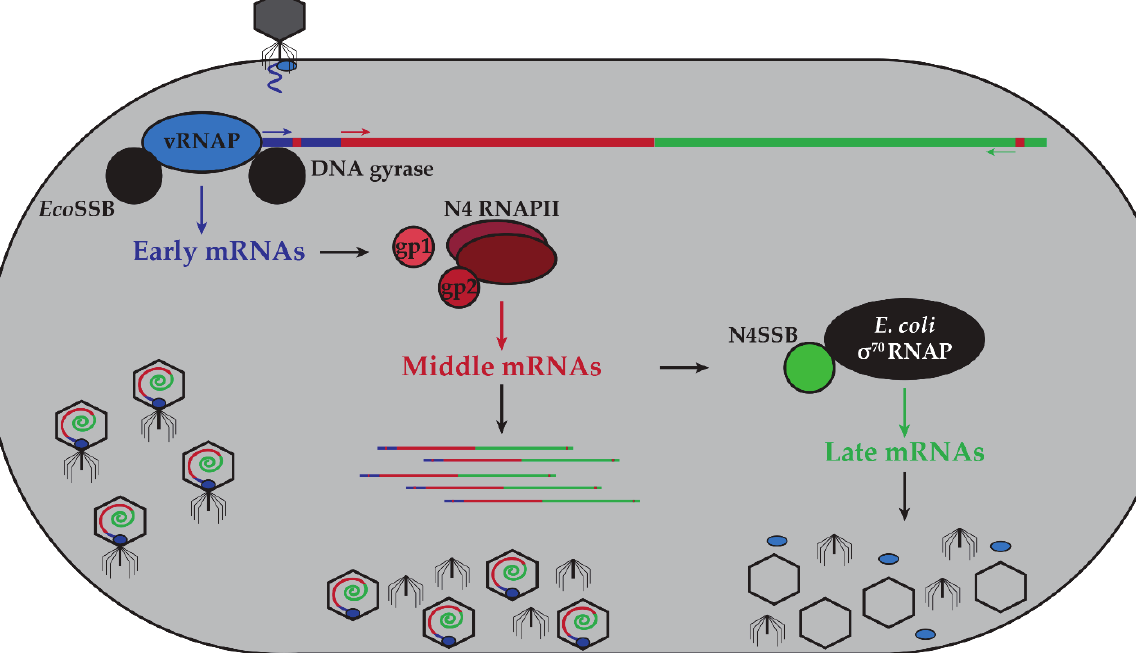
Figure 1. Schematic of transcriptional program controlling the N4 life cycle. Upon interaction with its receptor, NfrA, N4 injects vRNAP and genomic DNA into the host. Host DNA gyrase introduces negative supercoils into the phage genome, driving early promoter hairpin extrusion. Eco SSB stabilizes the hairpin structures, allowing vRNAP to initiate transcription from early promoters to transcribe early genes required for middle transcription and transport the genome into the host cytoplasm. The early gene products gp1 and gp2 act as cofactors for the heterodimeric polymerase N4 RNAPII (gp15 and gp16) to carry out middle transcription. These transcripts encode functions required for N4 DNA replication. One such protein, N4SSB, interacts with host (cid:4) 70 -RNAP, redirecting it to late promoters. The late genes encode morphogenetic proteins involved in virion assembly, DNA and vRNAP packaging, and host lysis. Host proteins depicted in black, phage-encoded early transcriptional machinery in blue, phage-encoded middle transcriptional machinery in shades of red, and phage-encoded late transcriptional machinery in green. Arrows indicate polarity of